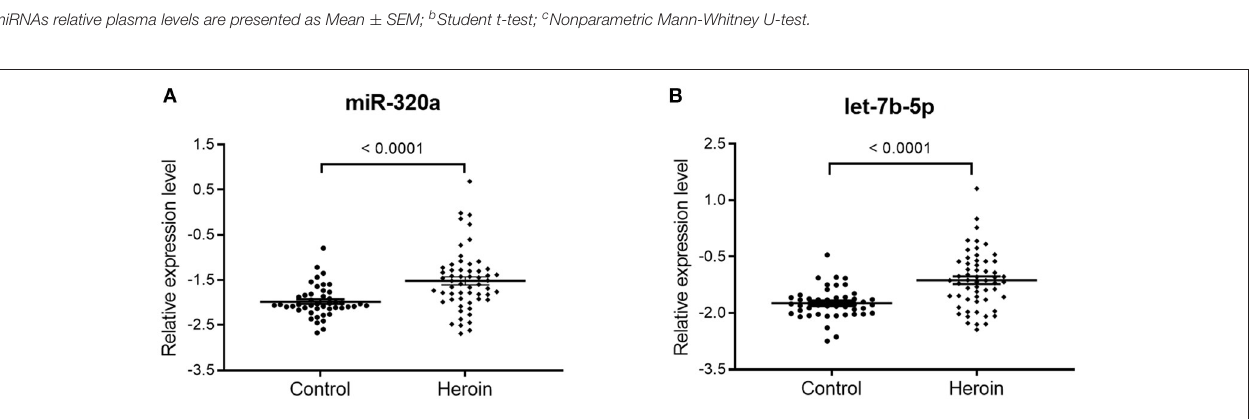
FIGURE 3 | The differential expression of miR320a and let-7b-5p between heroin-dependent patients and control subjects. A total of 57 heroin-dependent patients and 46 healthy controls in the training and validation sets were used to analyze the difference. (A) miR-320a (Mann-Whitney U -test; Control group vs. heroin group,